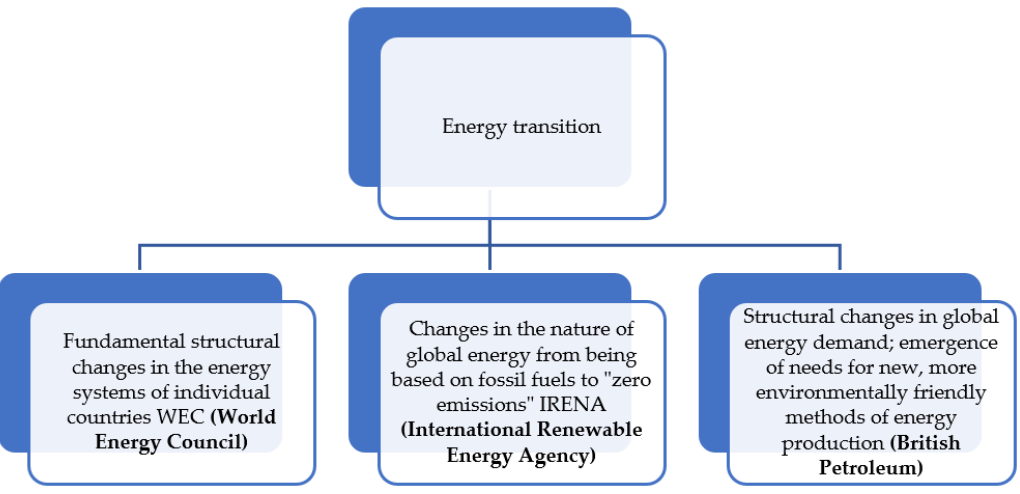
Figure 2. Approaches to defining «energy transition». Source: compiled by the authors based on [5,41,42]. The role of fossil fuels in the pattern of demand for energy sources has begun to be mix decreased by 6.1, 3.7, and 14.8% compared to 2018, respectively, and the growth in energy consumption in the world was provided only by alternative energy sources [5,43].